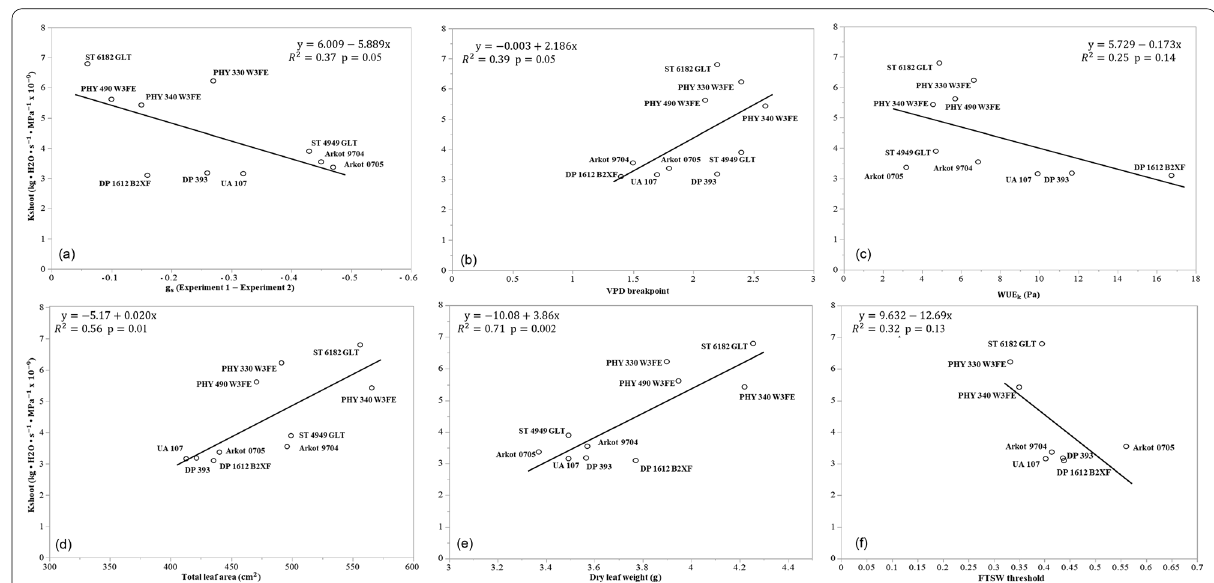
Fig. 3 Graphs of values of cotton cultivars’ average shoot hydraulic conductance (K shoot ) under a high evaporative demand [38 °C, vapor pressure deficit (VPD) > 3 kPa] in a controlled environment versus various drought tolerance parameters. Correlations include: K shoot and difference in stomatal conductance (g s , mol (H 2 O) m − 2 s − 1 ) between a low evaporative demand (32 °C, VPD 1 1.5 kPa) and a high evaporative demand · · = ∼ environment in controlled environments ( a ); vapor pressure deficit (VPD) breakpoint ( b ); water use efficiency coefficient (WUE k , Pa) ( c ); total leaf area (cm 2 ) ( d ); leaf dry weight ( g ) and ( e ); and fraction of transpirable soil water (FTSW) threshold under progressive soil drying ( f ). R 2 ( a ); R 2 0.39, P 0.05 ( b ); R 2 0.25, P 0.14 ( c ); R 2 0.56, P 0.01 ( d ); R 2 0.71, P 0.002 ( e ); R 2 0.32, P 0.13 ( f = = = = = = = = = =